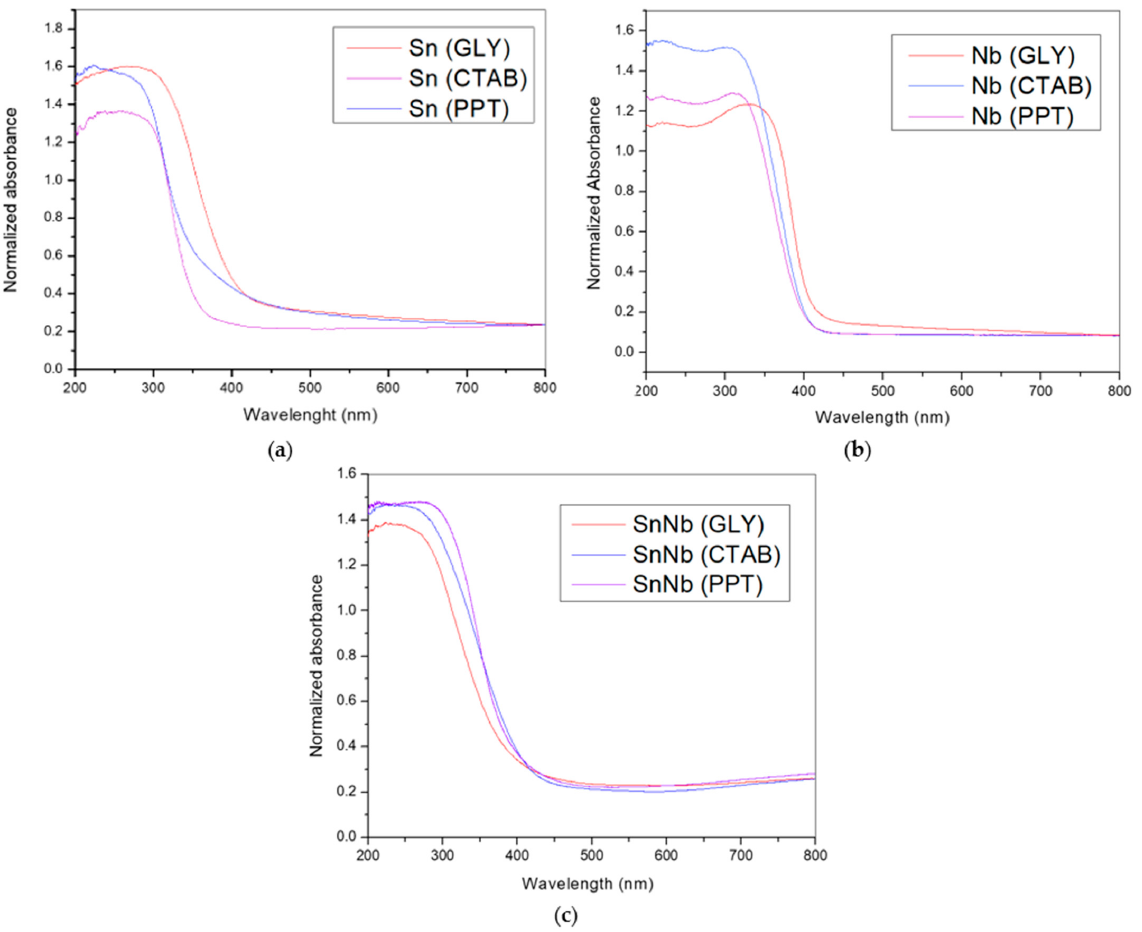
Figure 4. DRS-UV–vis spectra of the catalysts: ( a ) Sn(PPT), Sn(CTAB) and Sn(GLY); ( b ) Nb(PPT), Nb(CTAB) and Nb(GLY); and ( c ) SnNb(PPT), SnNb(CTAB) and SnNb(GLY).